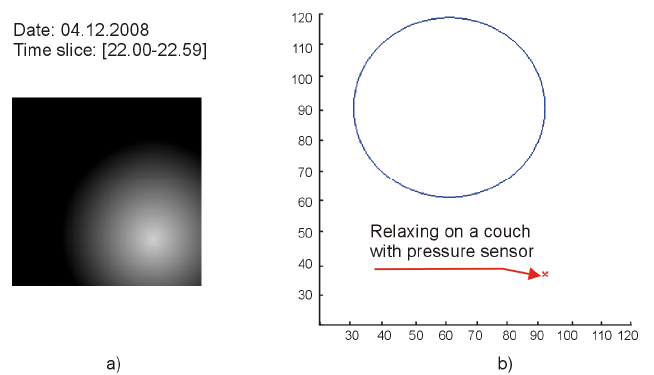
Figure 12. Kasteren House C dataset: An illustration of a false alert, due to a pressure sensor that reports a high level of activity when the user was actually relaxing on a couch. ( a ) the activity map ( b ) the plot of the centroid of the activity map vs. the SBC of the centroids for the corresponding time slices of the reference interval.